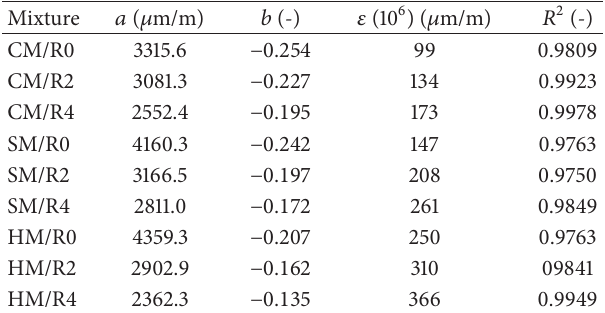
Table 7: Regression coefficients of the fatigue curves: 𝑁 1 approach for unaged mixtures.